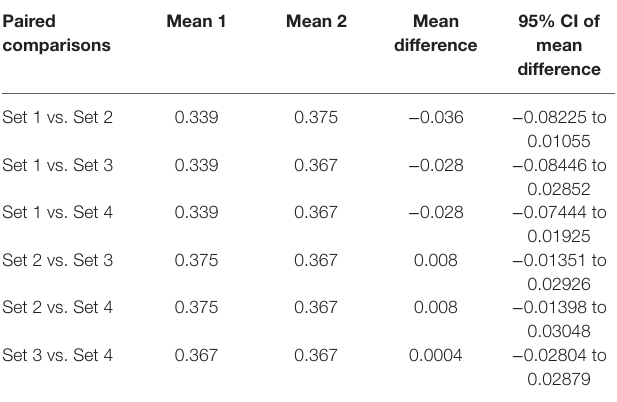
TABLE 2 | Pairwise comparisons matrix for resistance measurements. Paired